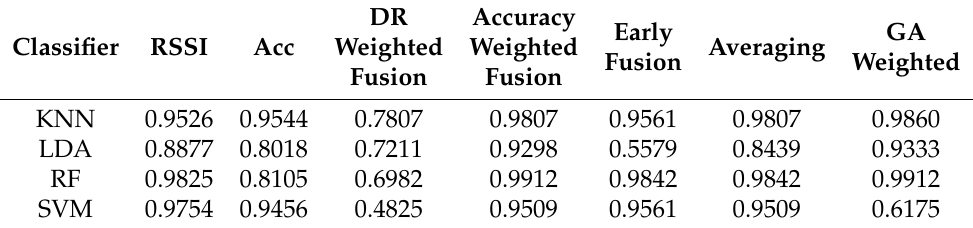
Table 6. Accuracy values for the kitchen gateway.